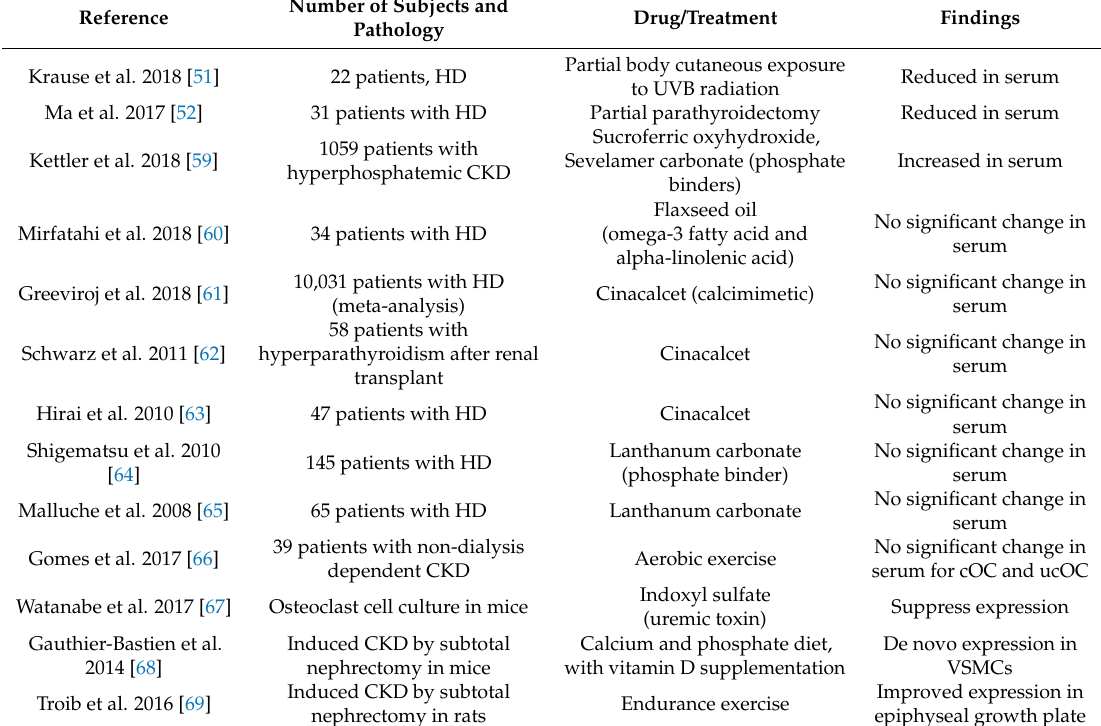
Table 6. Interventional studies on